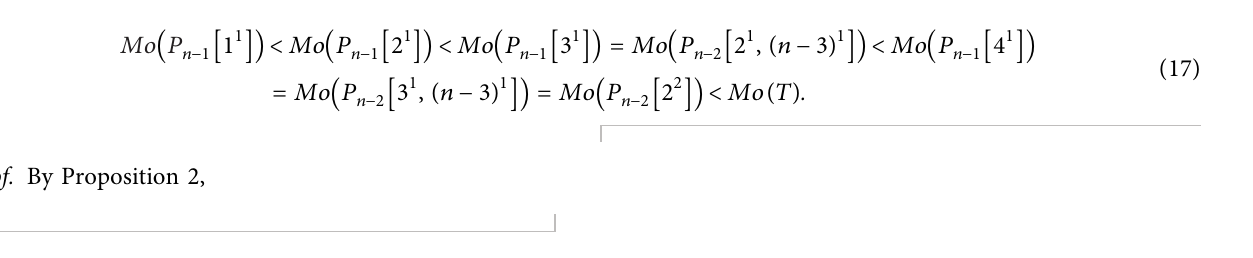
, and G in Transformation 4. (a) G 1 2